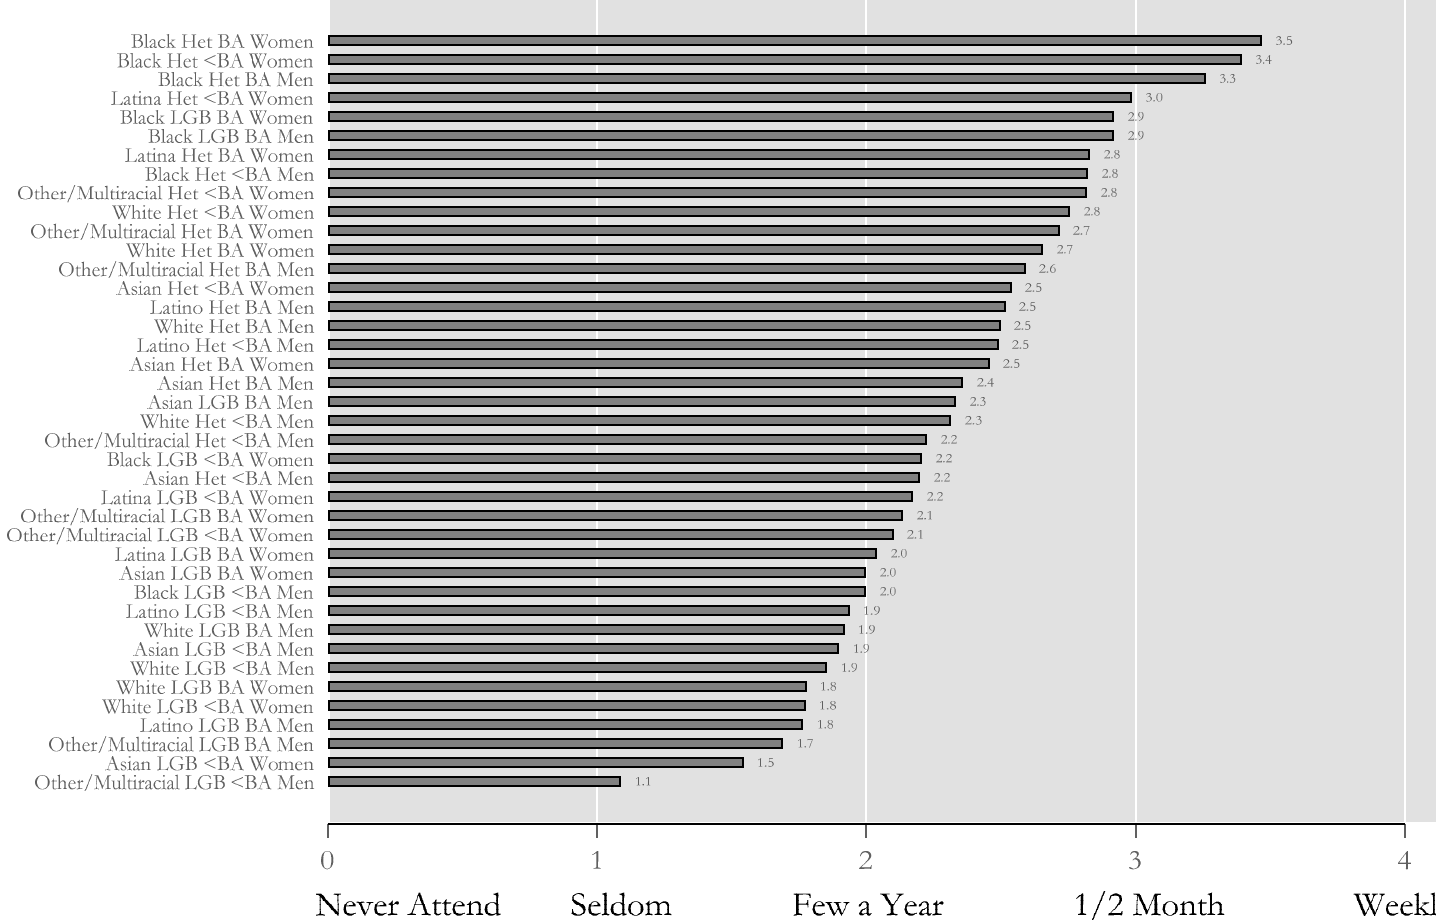
Figure 4. Religious service attendance frequency across configurations of status characteristics, RLS (N = 33,334).